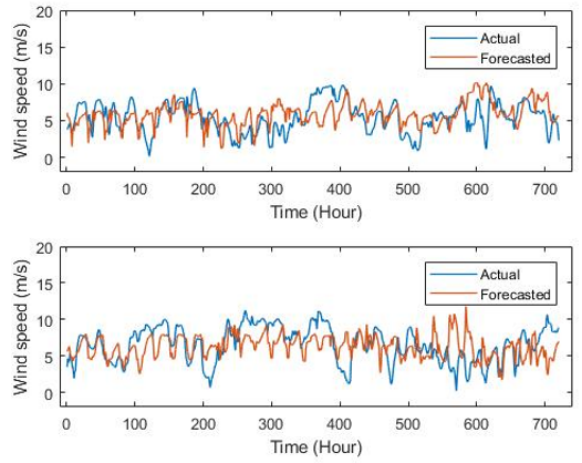
Figure 13. Forecasted and actual wind speeds of 2017, Jan & Feb, Khafji Case